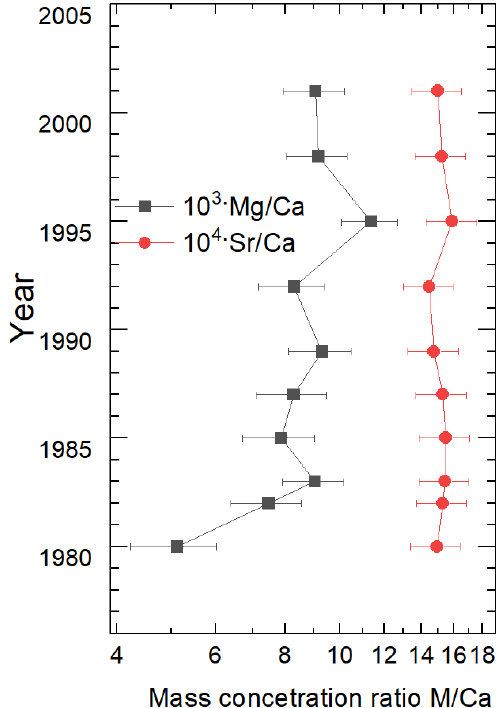
Figure 7. Change in mass concentration of Mg/Ca and Sr/Ca ratios in the Korana River tufa layers over time (M = Mg, Sr).